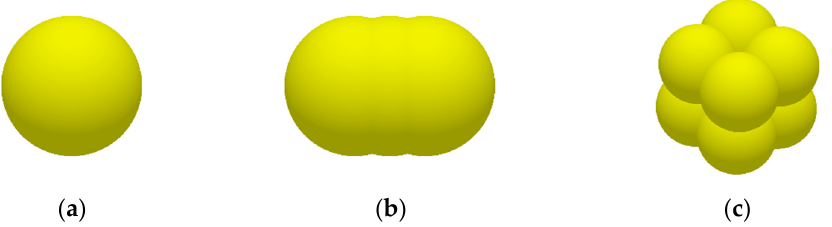
Figure 7. Sandy loam soil particle model. ( a ) Granular particle; ( b ) Columnar particle; ( c ) Agglom- erated particle.